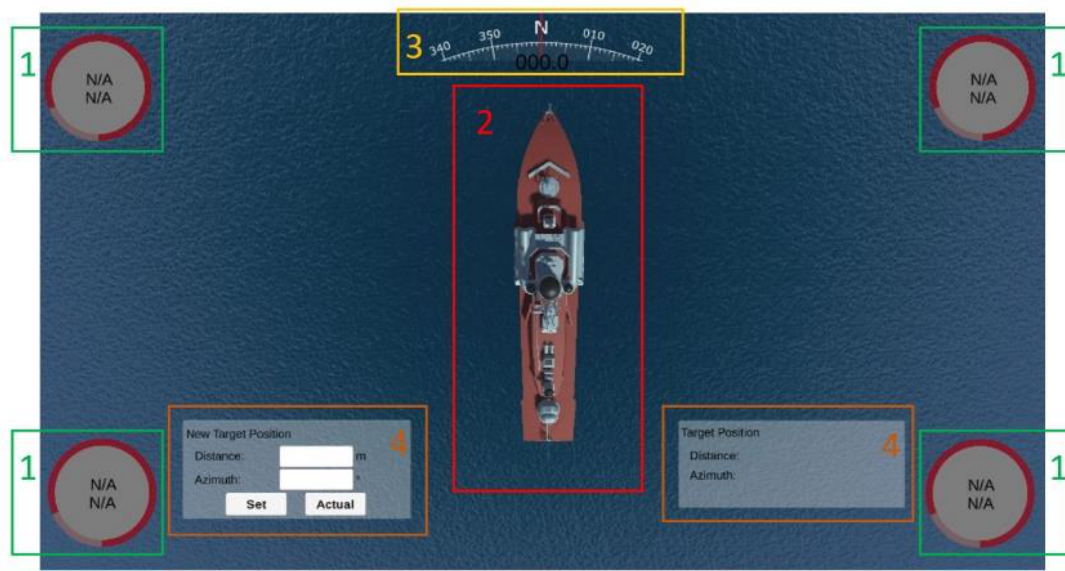
Figure 16. The user interface.